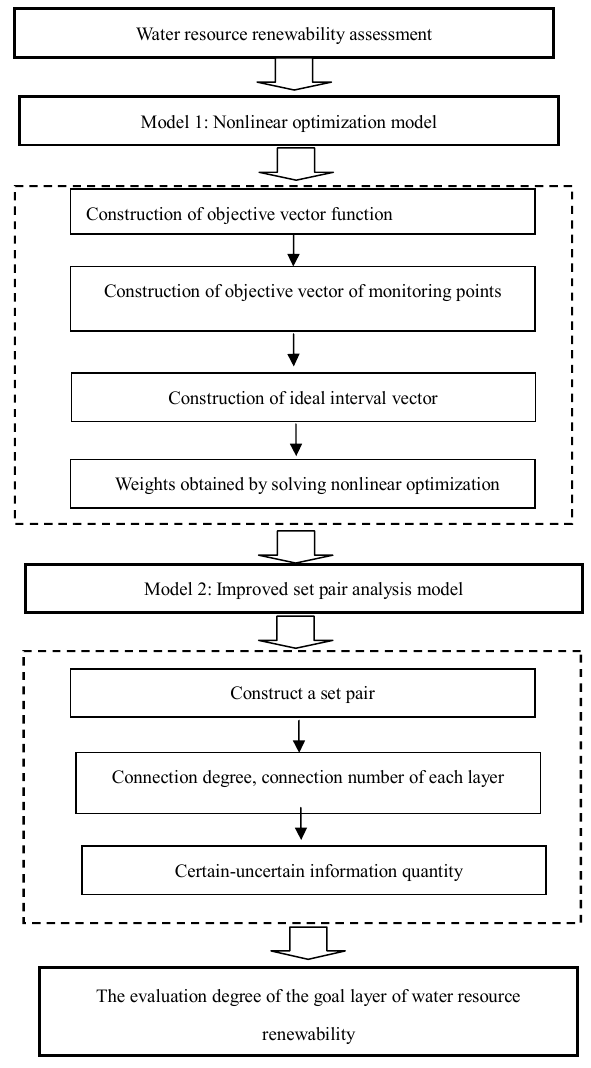
Fig.1 The basic flow chart of NOSPAM for water resource renewability assessment Fig. 1. The basic flow chart of NOSPAM for water resource re- newability